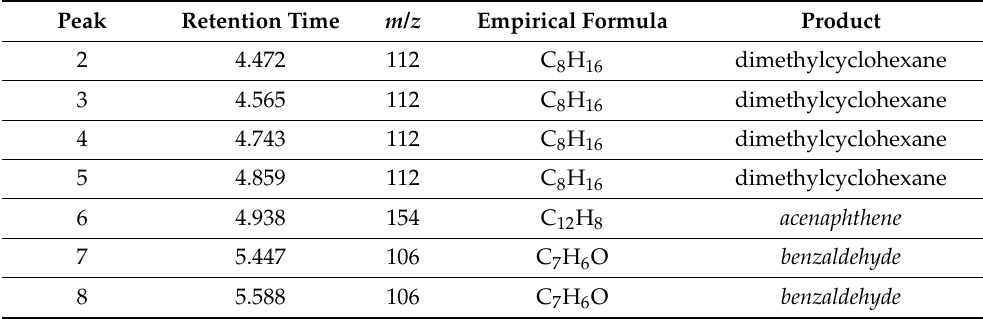
Table 3. GC-MS data of the main products from photocatalytic degradation of PAHs over TiO 2 /CQDs/CdIn 2 S 4 . Peak Retention Time m / z Empirical Formula Product